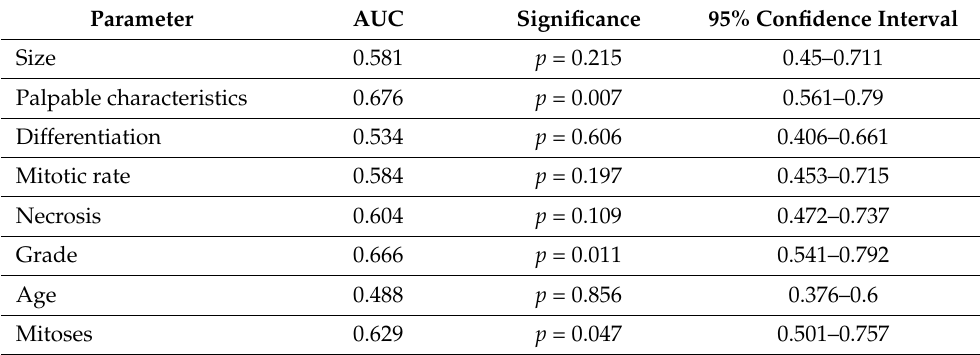
Table 1. AUC of ROC curve for individual parameters in the Clinical_train